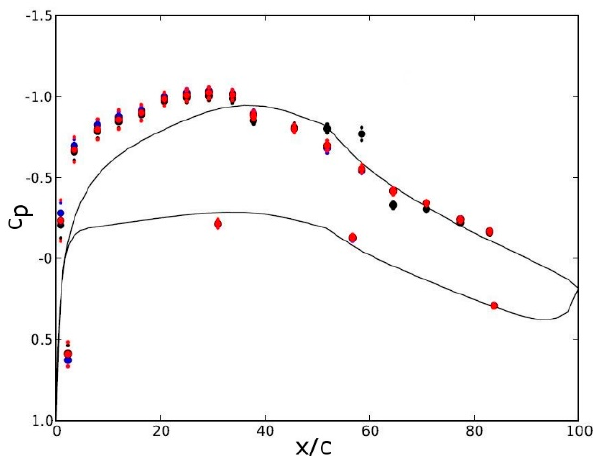
Figure 41. Free-flight measurements for Re = 390,000 and α = 0.3 degrees. Black symbols: Uncontrolled flow. Red symbols: F + = 1.05 and B = 0.05. Blue symbols: F + = 0.75 and B = 0.05. Solid line: XFoil. (Reprinted by permission of the American Institute of Aeronautics and Astronautics, Inc. (Reston, VA, USA) from [37]).